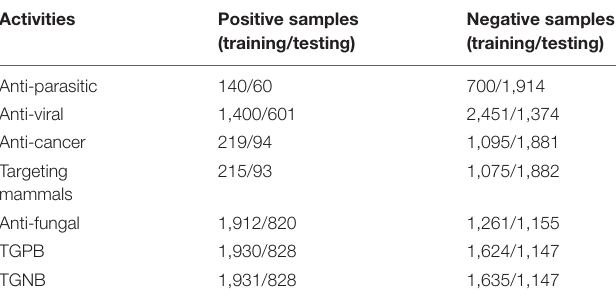
TABLE 1 | The Number of AMPs of seven AMP functional activities on training set and testing set for DS1 and DS2. Activities